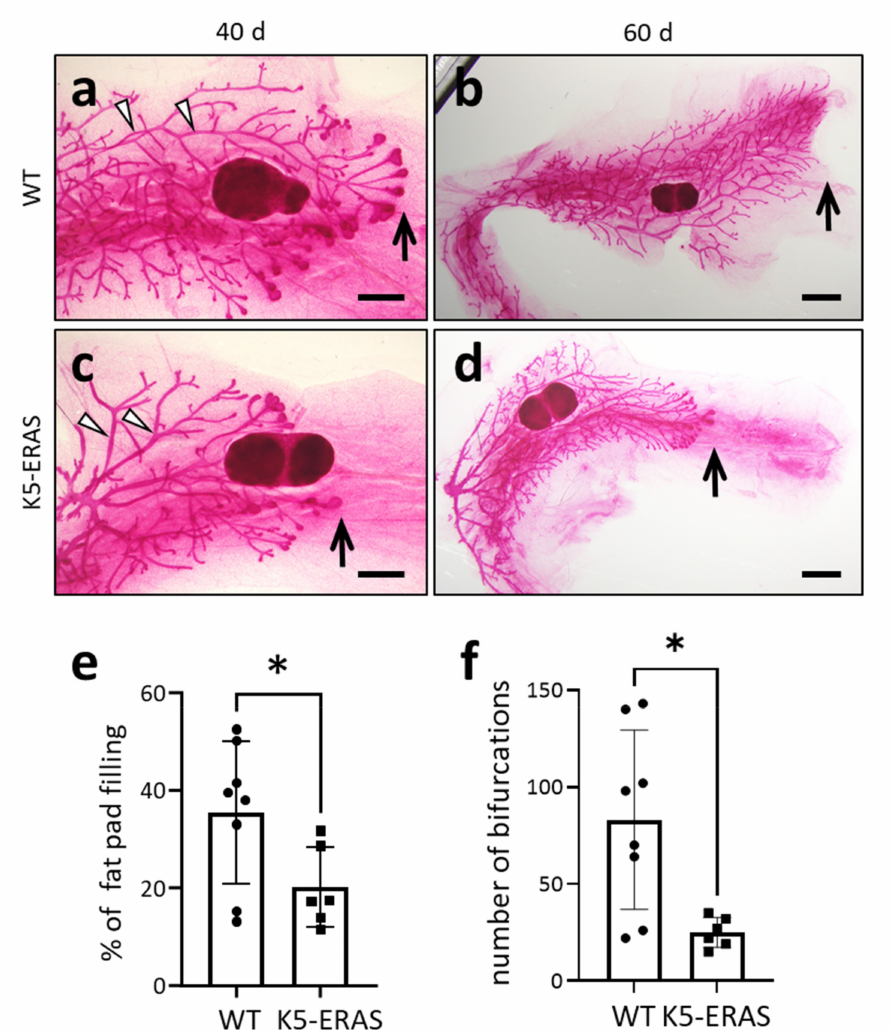
Figure 4. Delayed development of K5-ERAS mammary glands. ( a – d ) Representative images of whole mount carmine alum staining of the 4th mammary glands of WT ( a , b ) and K5-ERAS ( c , d ) mice of 40- ( a , c ) and 60-day-old ( b , d ) female mice. Note that the terminal end buds overtook the lymph nodes (the darker, round, dense islet in the center of the images) in WT (arrow in ( a )) and not in 40-day-old K5-ERAS females (arrow in ( c )). Note that the mammary ducts were wider in K5-ERAS (arrowheads in ( c )) than in WT females (arrowheads in ( a )). In 60-day-old females, the maturation delay in K5-ERAS females persisted, since the ductal tree did not colonize the whole fat pad (arrow in ( d )) as in WTs (arrow in ( b )). These results were obtained studying groups of 6 WT and 5 K5-ERAS 40-day-old mice and 3 WT and 3 K5-ERAS 60-day-old mice. ( e ) Quantification of fat pad colonization by mammary epithelia in WT ( n = 4 mice) and K5-ERAS ( n = 3) 40-day-old female mice. ( f ) Quantification of the number of bifurcations found in the epithelial tree in 40-day-old mice * p < 0.05. Bar: 1 mm in ( a , c ), and 2 mm in ( b , d ). The arrowheads point to the mammary